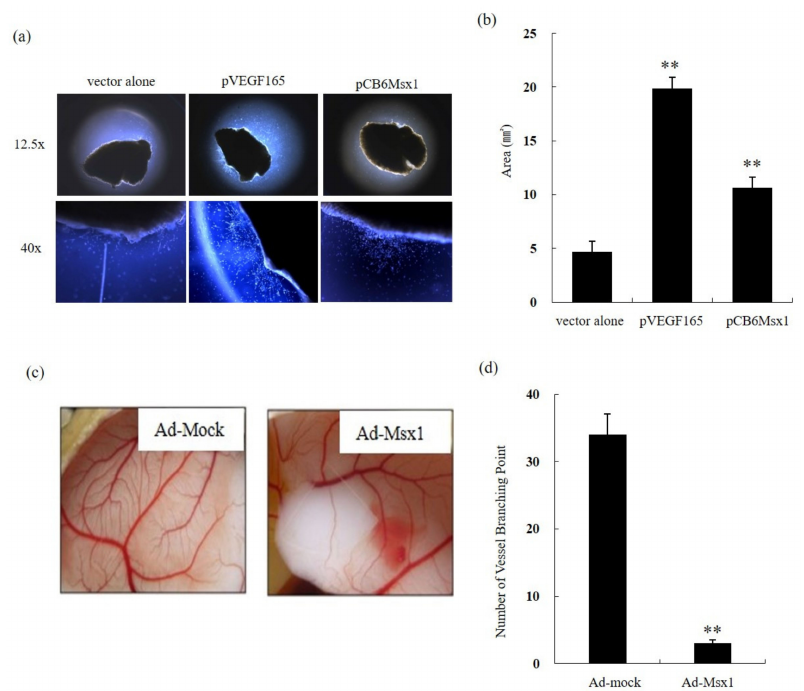
Figure 2. Msx1 inhibits vessel sprouting ex vivo and in vivo angiogenesis. ( a ) Cross-sections of a mouse tibialis anterior muscle injected with pVEGF165 or pCB6 Msx1 plasmid by electroporation were embedded in growth factor-reduced Matrigel. An outgrowth of capillary-like structures was observed with an inverted microscope. ( b ) The outgrowth was quantitated by measuring the area of capillary-like structures. ( c ) Ad-Msx1 inhibits angiogenesis in vivo. Ten-day-old chicken chorioallantoic membranes (CAMs) were treated with lysates obtained from cells infected with either Ad- β -gal or Ad-Msx1 virus. After 72 h, CAMs were harvested, and vascular density was assessed by microscopy. ( d ) Angiogenesis was quantitated by counting the number of branch points arising from the pre-existing vessels. Results were from three independent experiments. ** p < 0.01 indicates a significant di ff